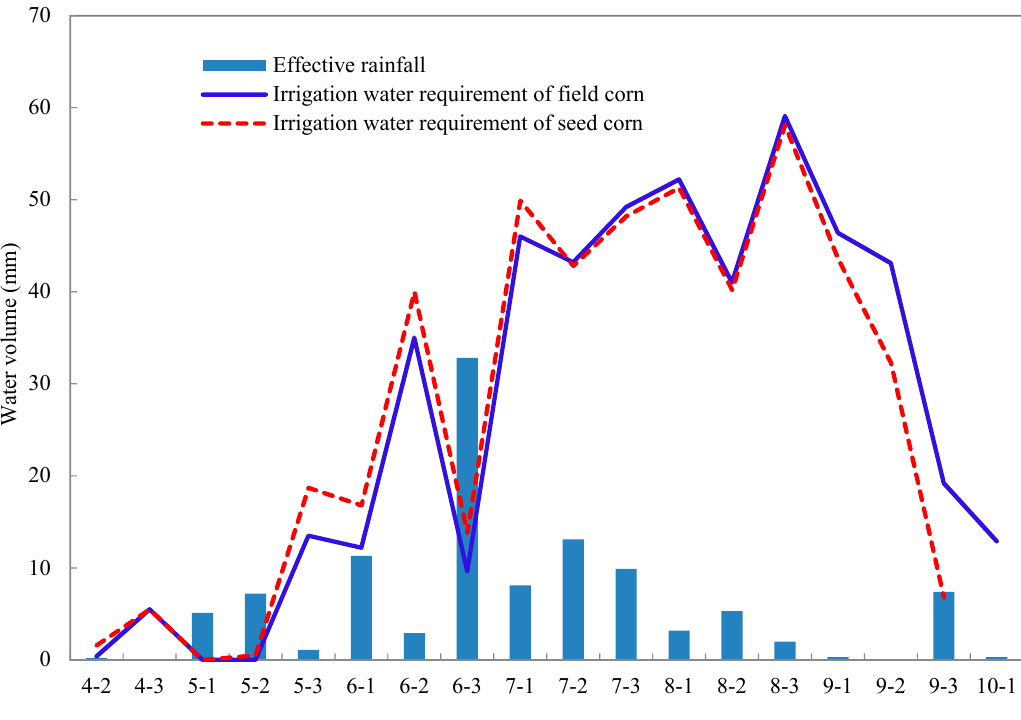
Figure 4. Irrigation water requirements of seed corn and field corn. Note: The meanings of figures in the horizontal axis are similar to those in Figure 3.